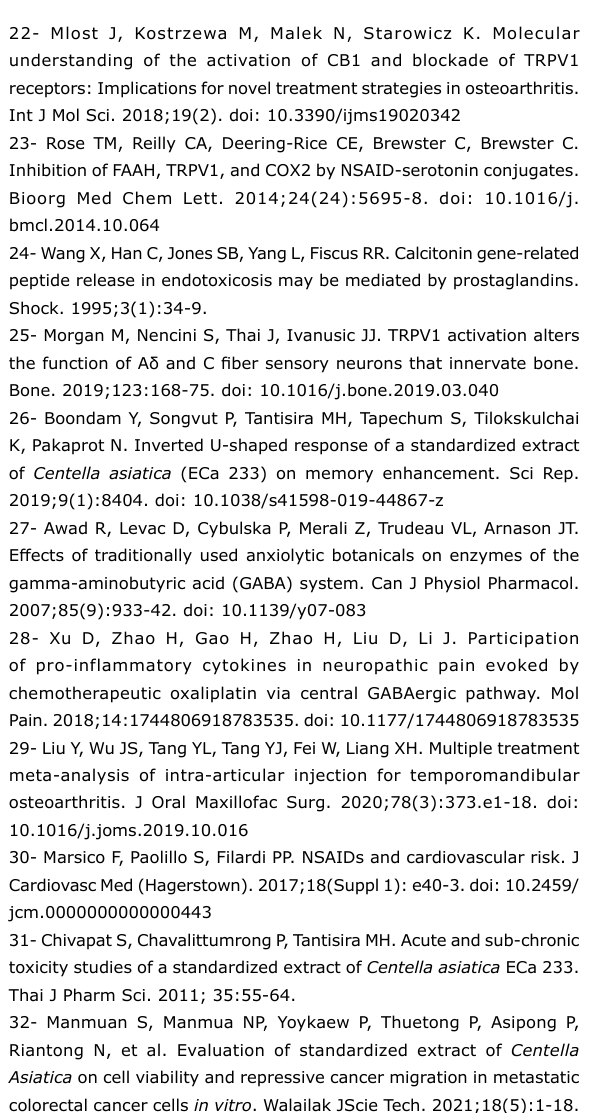
A standardized extract of Centella asiatica (ECa 233) prevents temporomandibular joint osteoarthritis by modulating the expression of local inflammatory mediators in